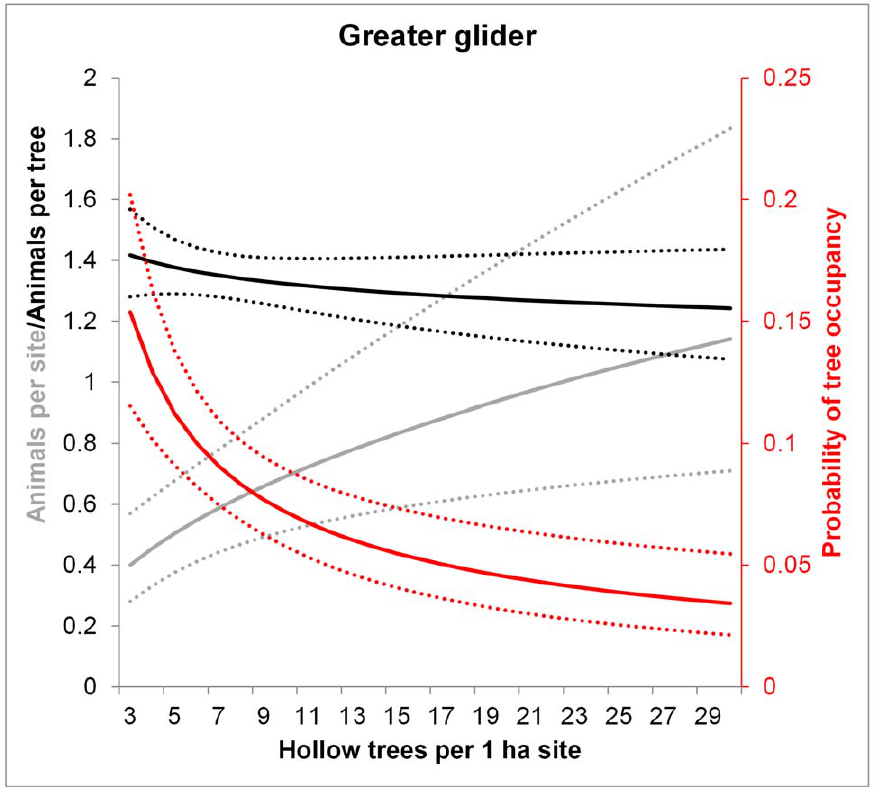
Figure 4. Model predictions for the greater glider of the number of animals per site (grey), the probability of occupancy per tree (red) and the number of animals per occupied tree (black) in relation to the number of hollow trees per 1 ha site. Dotted lines show 95% confidence intervals. Predictions were averaged over the non-represented variables (e.g. tree form). The number of animals per occupied tree (black lines) had a non-significant relationship with hollow tree